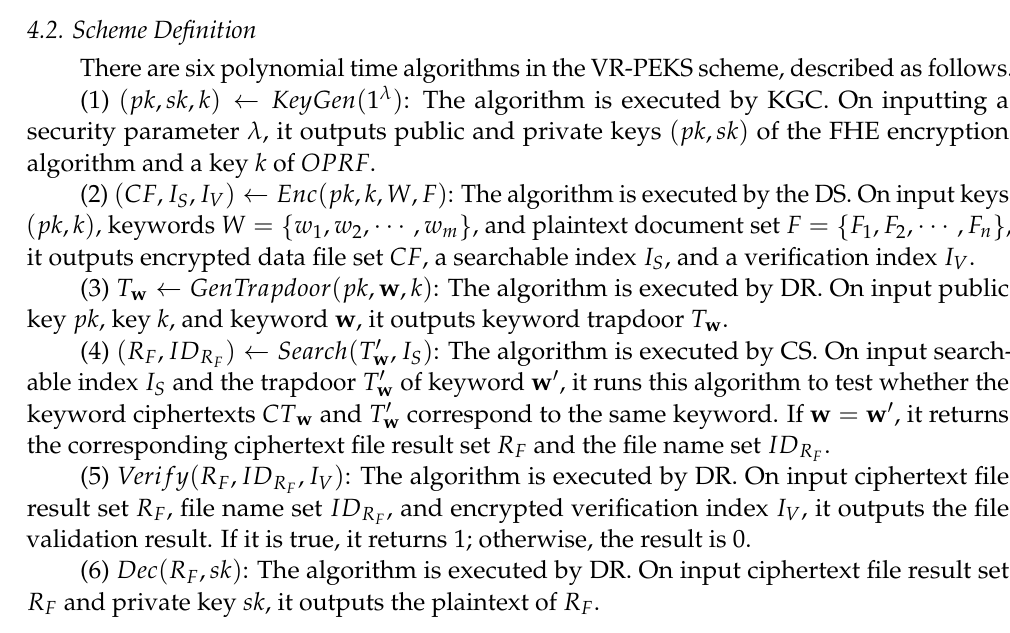
Figure 1. System model for the proposed VR-PEKS